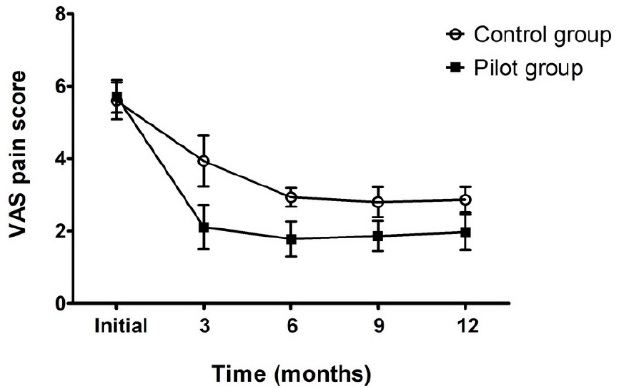
Figure 6. Evolution of pain over time in the control group ( n = 15) and pilot group ( n = 37), measured